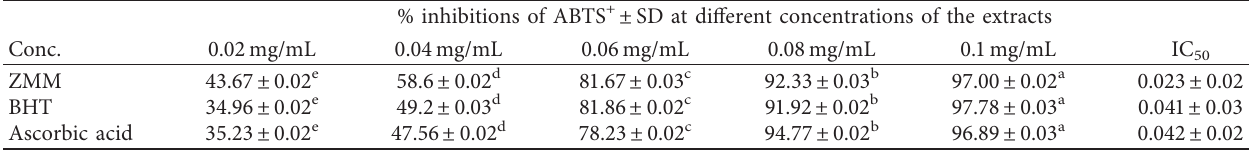
Table 3: ABTS inhibition (%) by the methanol extract of Z. mucronata . % inhibitions of ABTS + ± SD at different concentrations of the extracts